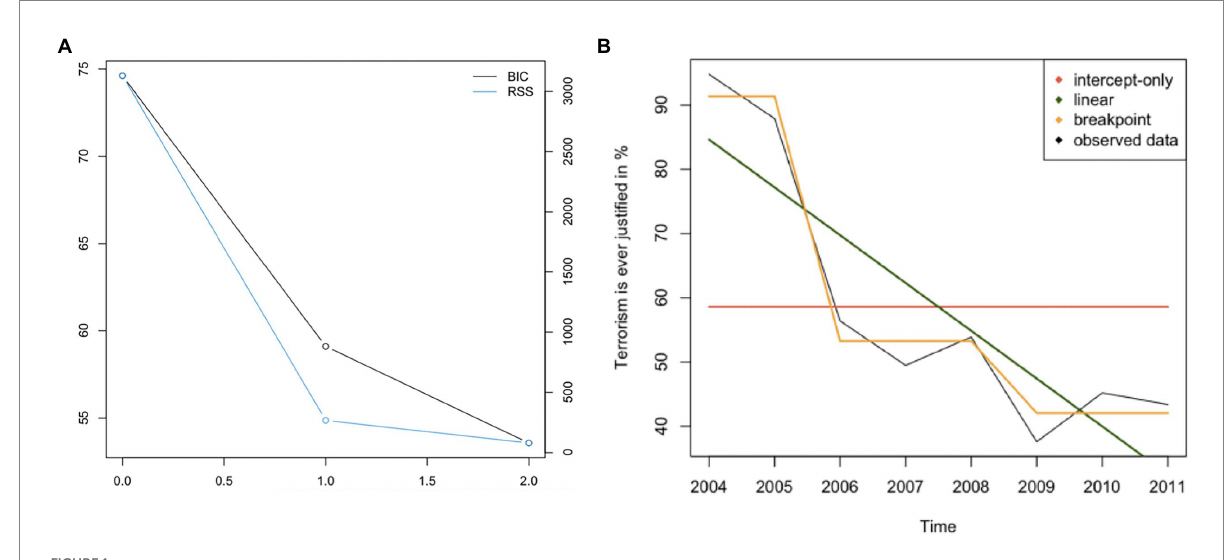
FIGURE 1 Panel (A) – BIC plot, Panel (B) - Plotting observed data and models for the time-series “Terrorism is ever